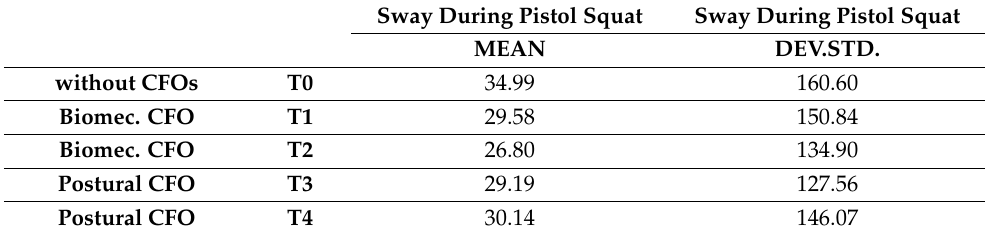
Table 5. Mean and standard deviation of sway data during Pistol